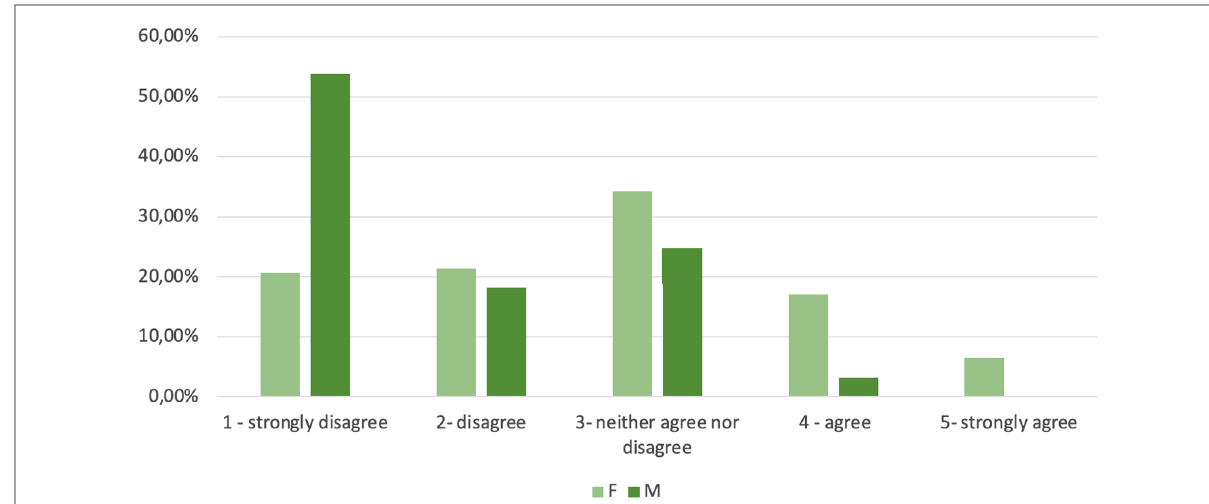
FIGURE 7 Percentage of Likert value attribution to the statement “ Sexist environment ” among male and female respondents in the group of respondents not choosing